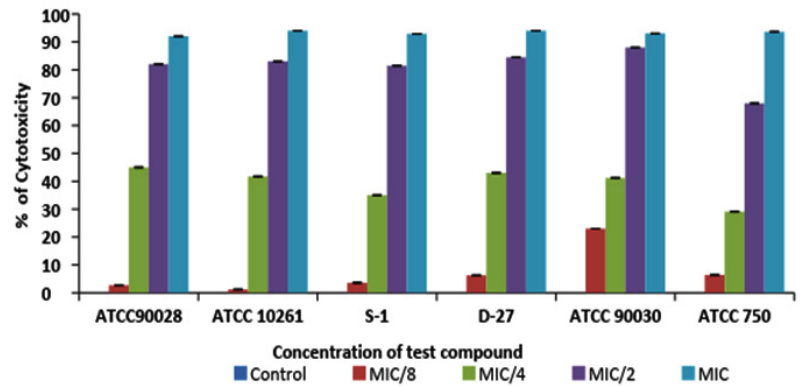
Fig. 3. The cytotoxic activity of geraniol against C. albicans (ATCC 90028 &10261), C. albicans D-27 , C. albicans S-1, C. glabrata (ATCC 90030), C. tropicalis (ATCC 750). Error bar lines represents ± SD to the mean value from